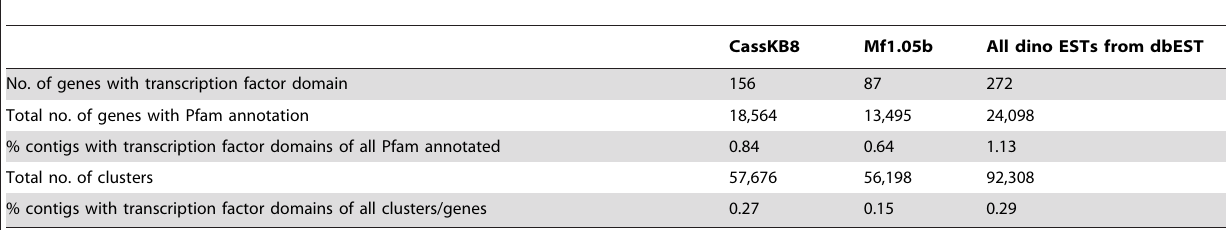
Table 6. Number of transcription factor domains found in Symbiodinium genes (based on 90% similarity clustering of contigs and singlets) and of all dinoflagellate ESTs available in Genbank dbEST.